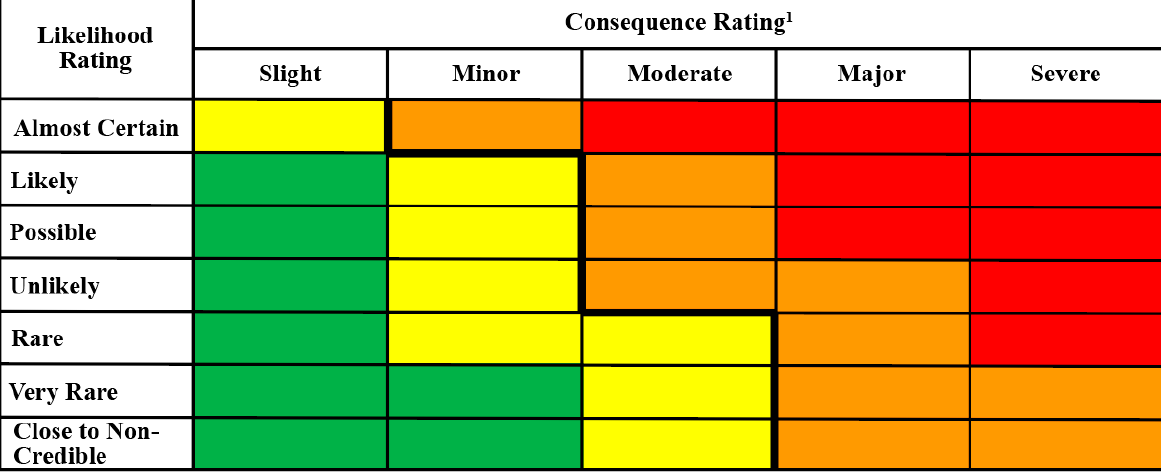
Figure 1. Example risk matrix considering major hazard aversion and threshold for quantitative analysis (Reprinted from Schafer et al. [2]).